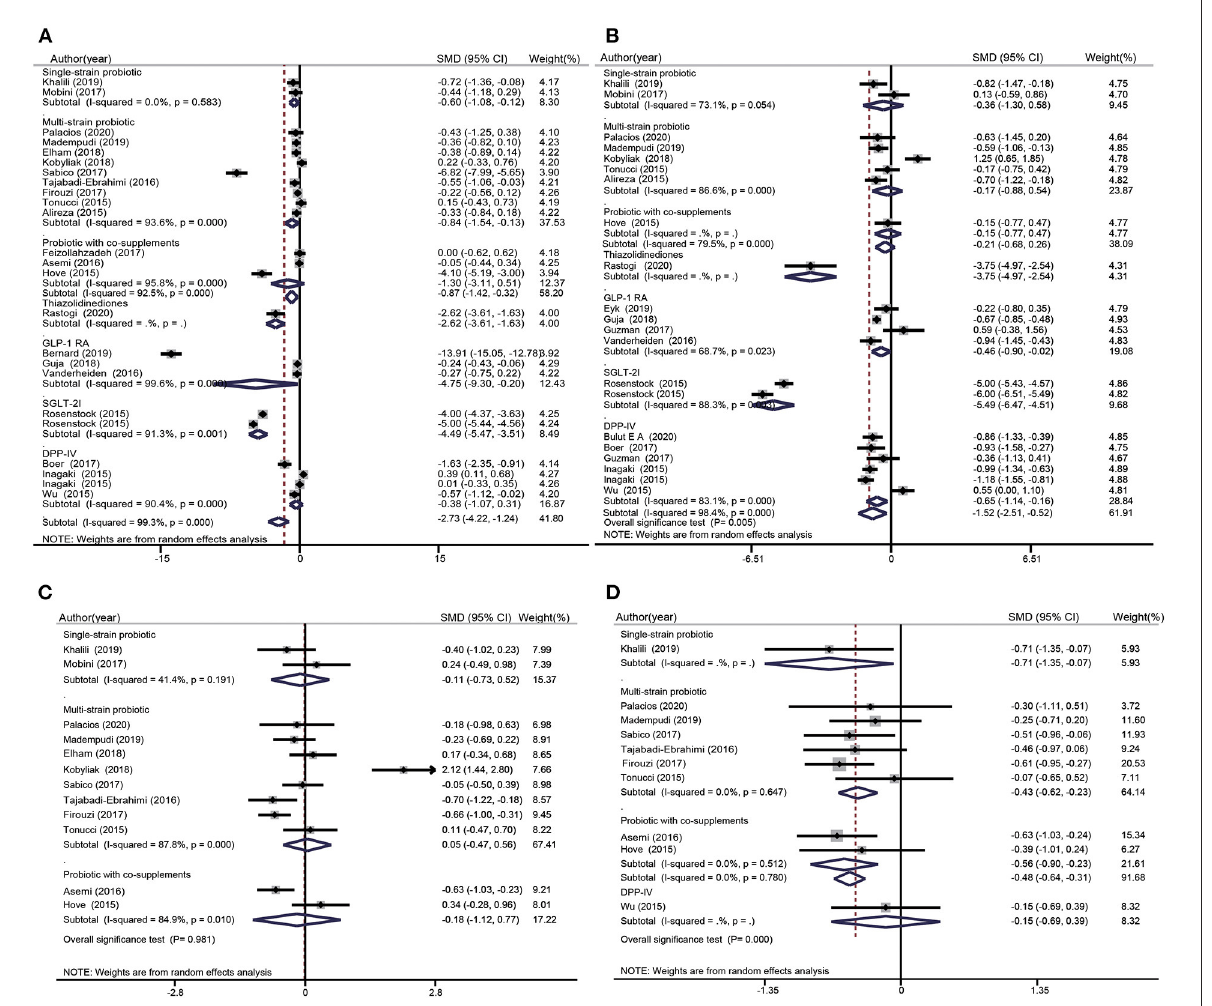
FIGURE3 Forest plots for the effect of probiotics supplementation and glucose-lowering drugs on FBS (mg/dL) (A) , HbA1c (%) (B) , Insulin (mU/mL) (C) , and HOMA-IR (D) , compared to placebo in pooled analysis. For each study, the solid black diamonds represent the point estimate of the intervention effect. The horizontal line joins the lower and upper limits of the 95% CI of this effect. The open diamonds represent the subgroup and overall SMD determined with a random-effects